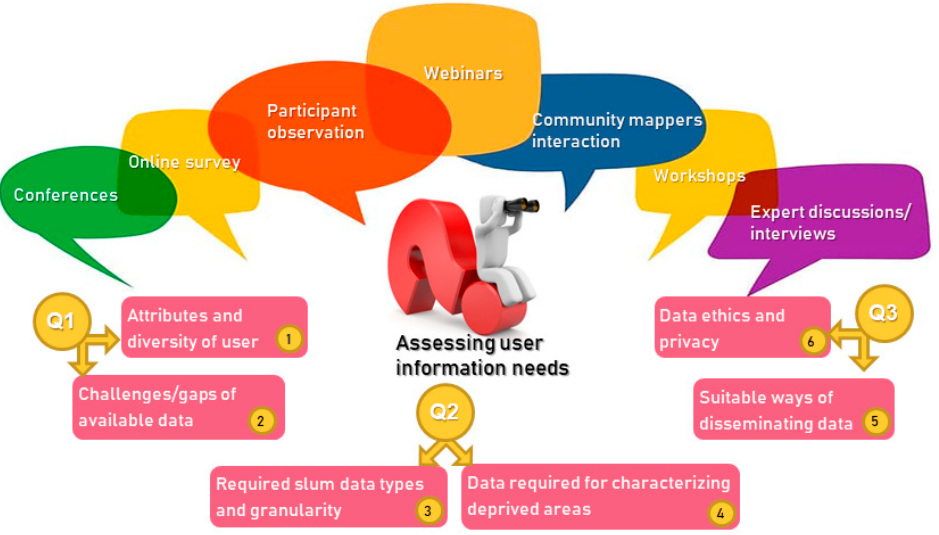
Figure 3. Assessing users’ information needs on deprived urban areas (Q1–3 refer to key questions detailed out in the section below).